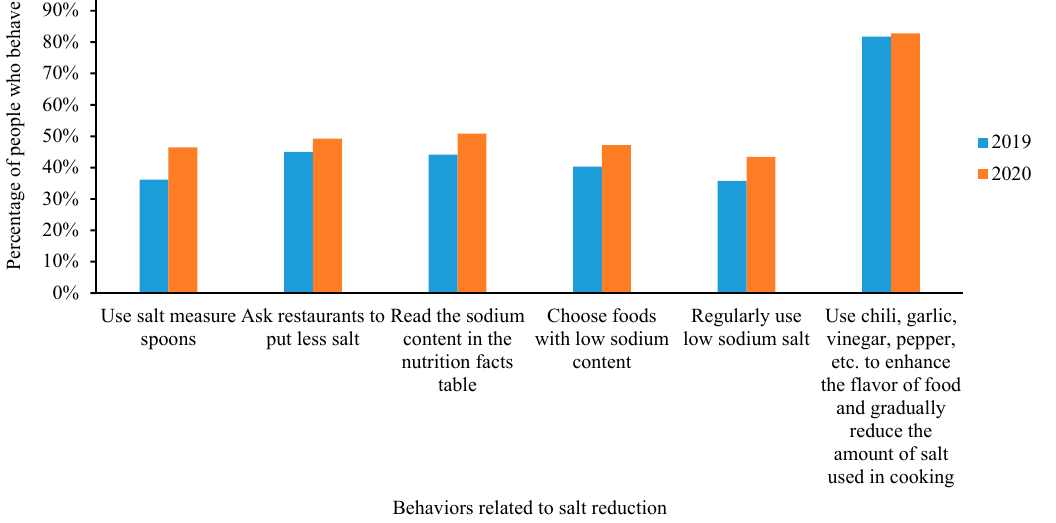
Figure 2. Comparison of behaviors status related to salt reduction between 2019 and 2020. Results of behaviors status related to high salt intake between 2019 and 2020 are shown in Figure